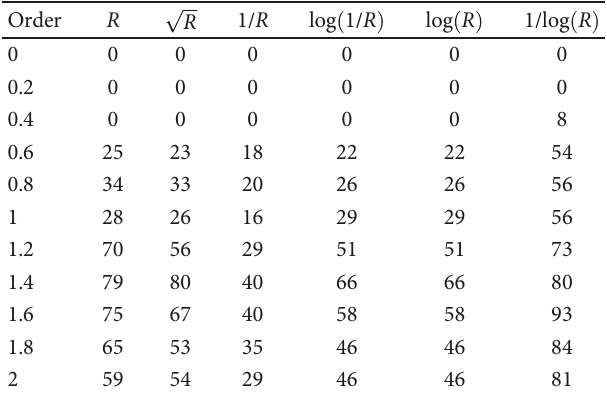
Table 2: The number of the bands through 0.01 level of signi fi cance test of correlation coe ffi